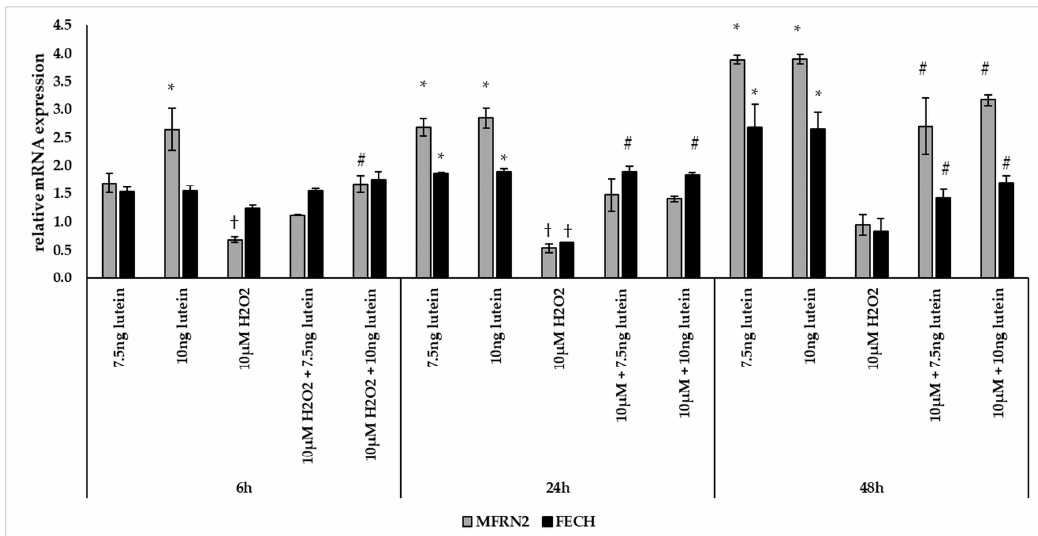
Figure 8. Effects of lutein and H 2 O 2 treatment on mRNA expressions of MFRN2 and FECH. The columns represent the mean values, and error bars indicate the standard deviation (SD) of three independent experiments ( n = 3), each performed in triplicate, and are presented relative to own control cells. * indicates statistical significance of lutein treatments versus controls; † indicates statistical significance of H 2 O 2 -treated cells compared to controls; # indicates statistical significance of combined (lutein with H 2 O 2 ) treatments compared to H 2 O 2 treatments; the level of significance was p < 0.05. Real-time PCR was performed with the SYBR green protocol using gene-specific primers. β -actin was used as house-keeping gene for the normalization. The relative expression of controls was regarded as 1.